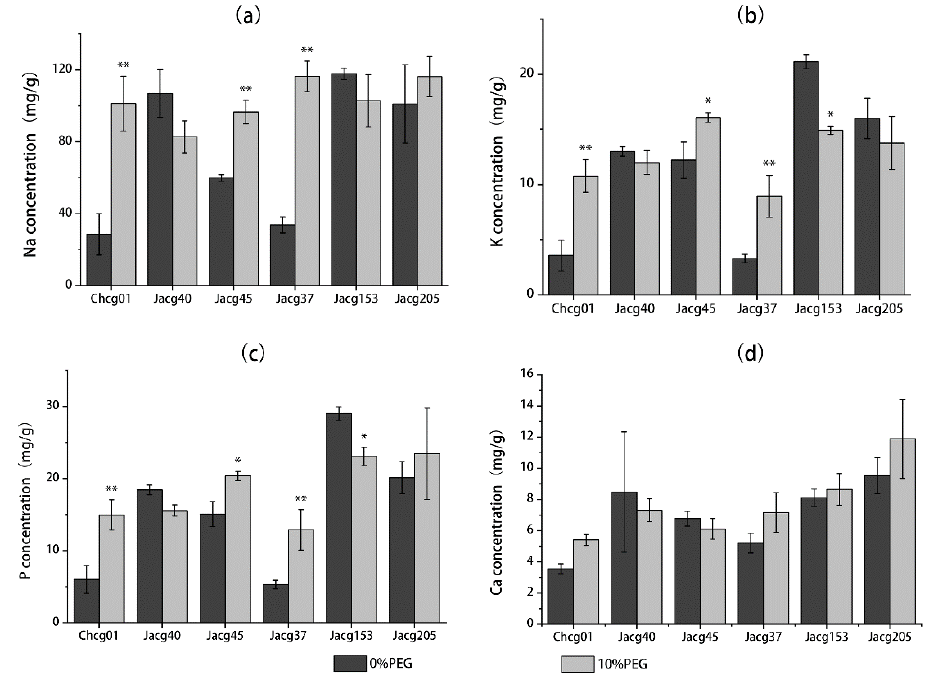
Figure 3. The sodium (Na, ( a )), potassium (K, ( b )), phosphorus (P, ( c )) and calcium (Ca, ( d )) concen- trations in the mycelia of six strains of Cenococcum geophilum under drought treatment. The mycelia were pre-cultured in a modified MMN medium for 30 days, followed by the drought treatment (10% PEG-6000) for 30 days. PEG-6000 was not added into the control treatment. Data are shown as mean ± SD of the replicates (n = 3). Significant difference of each element concentration of each isolate between 0% and 10% PEG-6000 treatments is tested by using the Welch ’s t -test. * p < 0.05; ** p < 0.01.